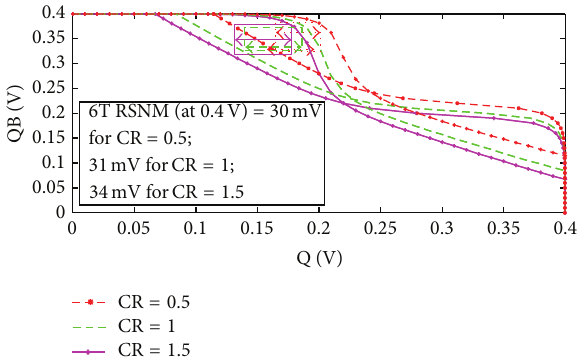
Figure 12: RSNM of 6T with varying CR.